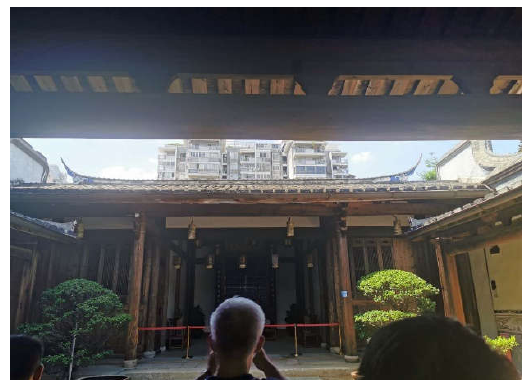
Figure 1 An architectural heritage and its surrounding environment in a city in southern China